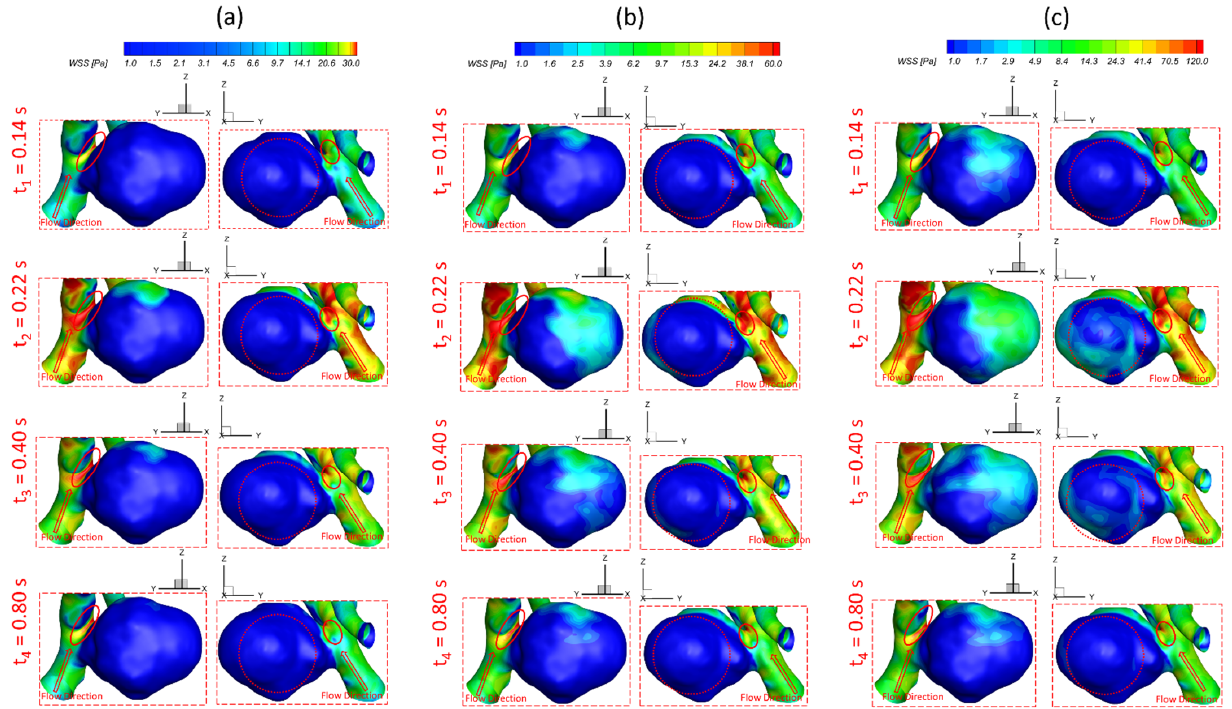
Figure 5. Visualized instantaneous WSS distributions on selected region (R2) of ICASA − 2 model at selected instants and shunt ratio of q A1 :q A2 = 75:25 under corresponded PFRs: ( a ) PFR−I, ( b ) PFR−II, and ( c ) PFR−III.